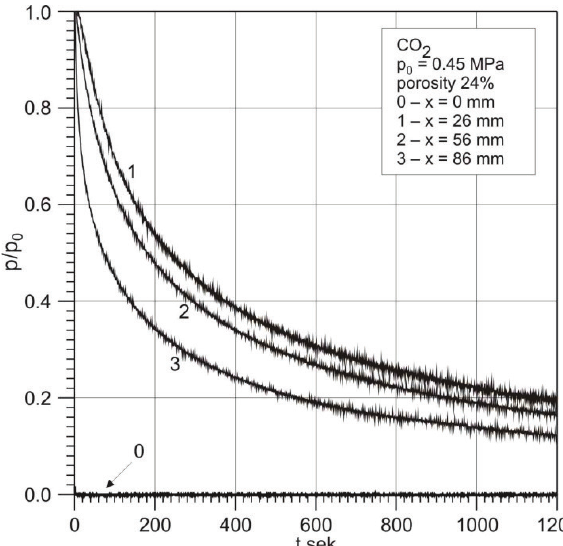
Figure 9: Removing carbon dioxide from briquettes - the bottom of the briquette is